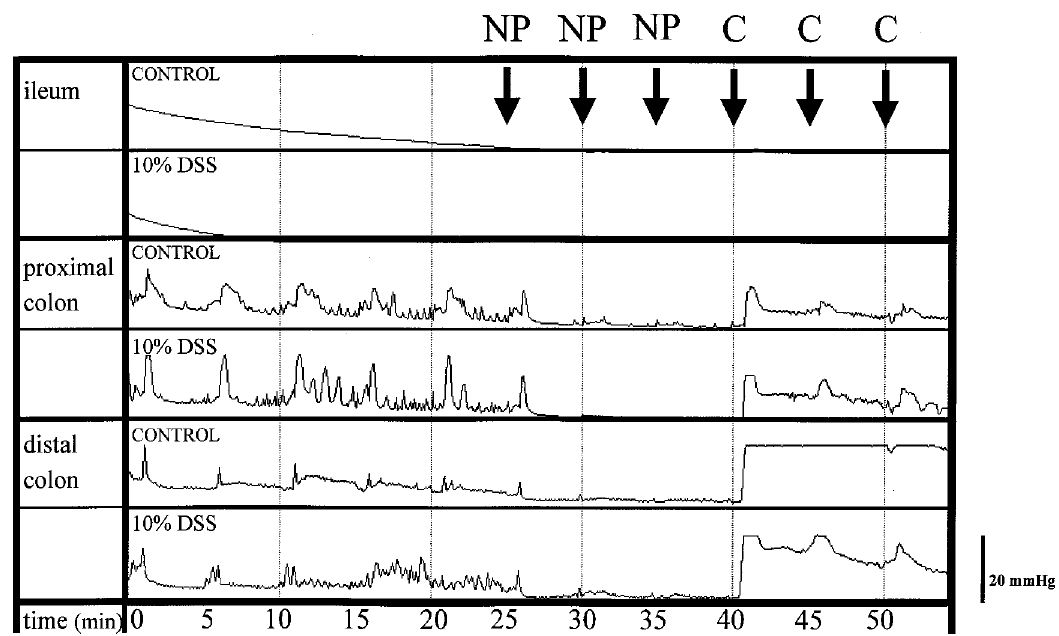
FIG. 3. Contractility, simultaneously measured with permeability (see Fig. 2) and serosal influenced by nitroprusside (NP) and carbachol (C) at various time